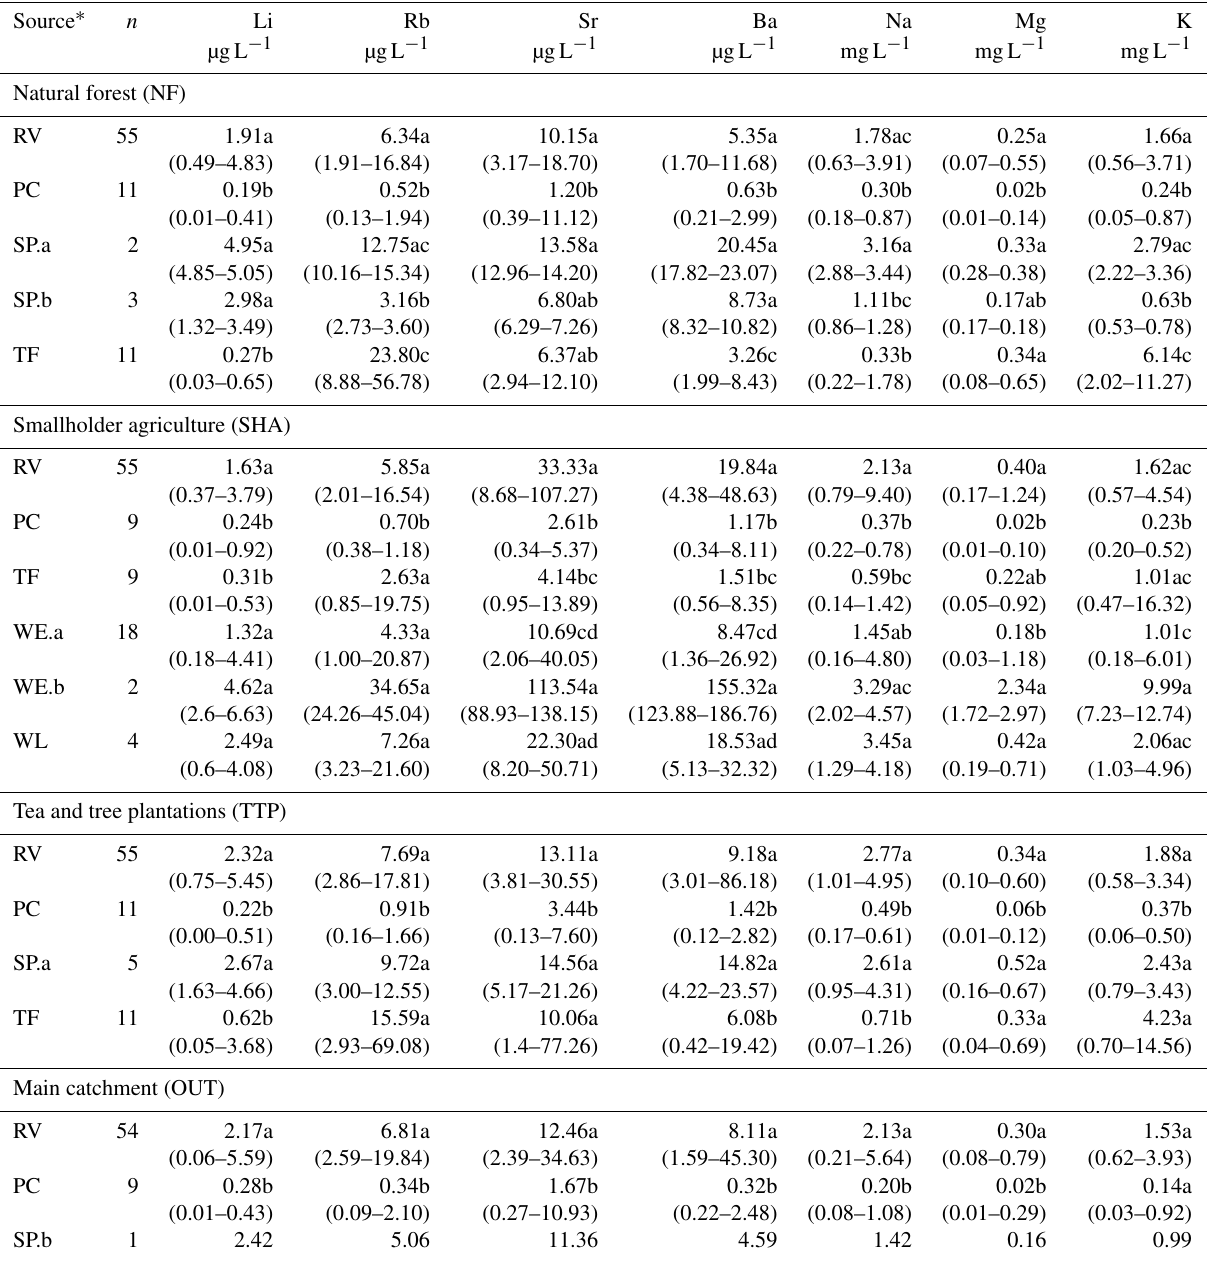
Table 3. Number of samples ( n ), median and range (in parentheses) solute concentrations for all sampled endmembers and stream water collected between 15 October 2015 and 21 October 2016 in the South-West Mau, Kenya. Different letters after median values indicate significant differences in solute concentrations between